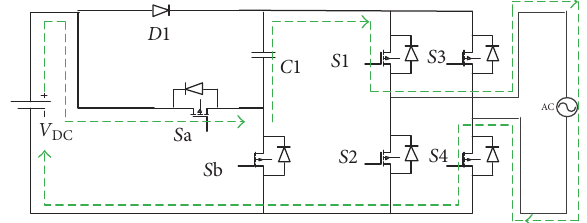
Figure 4: Switching operation for 2 𝑉 -level output.